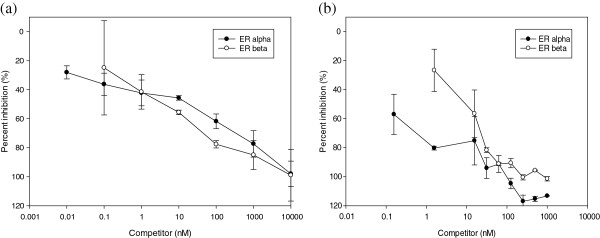
Competitive binding curves illustrating the binding of A. pilosa to ERα and ERβ. The results are expressed as mean ± SD values. (a) The binding affinity of E2 to ERα and ERβ, and (b) the binding affinity of A. pilosa to ERα and ERβ.